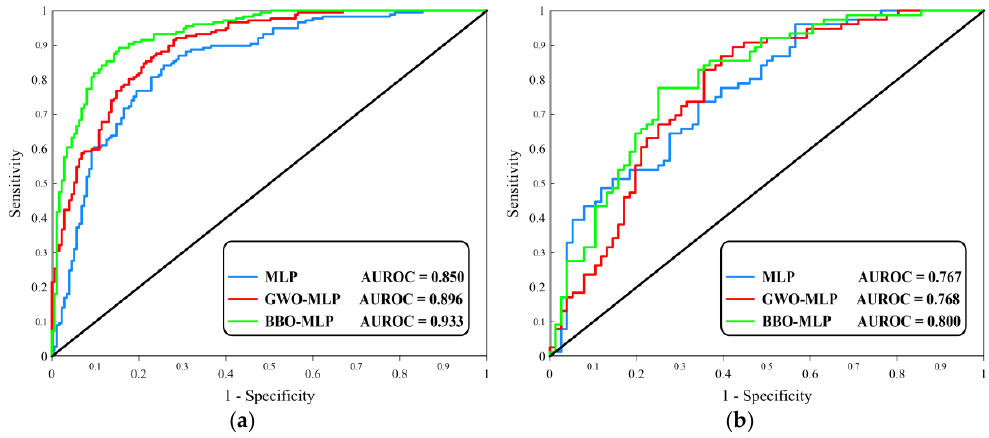
Figure 13. The ROC diagrams plotted for the ( a ) training and ( b ) testing data. Table 3. The obtained accuracy criteria in the training and testing phases.